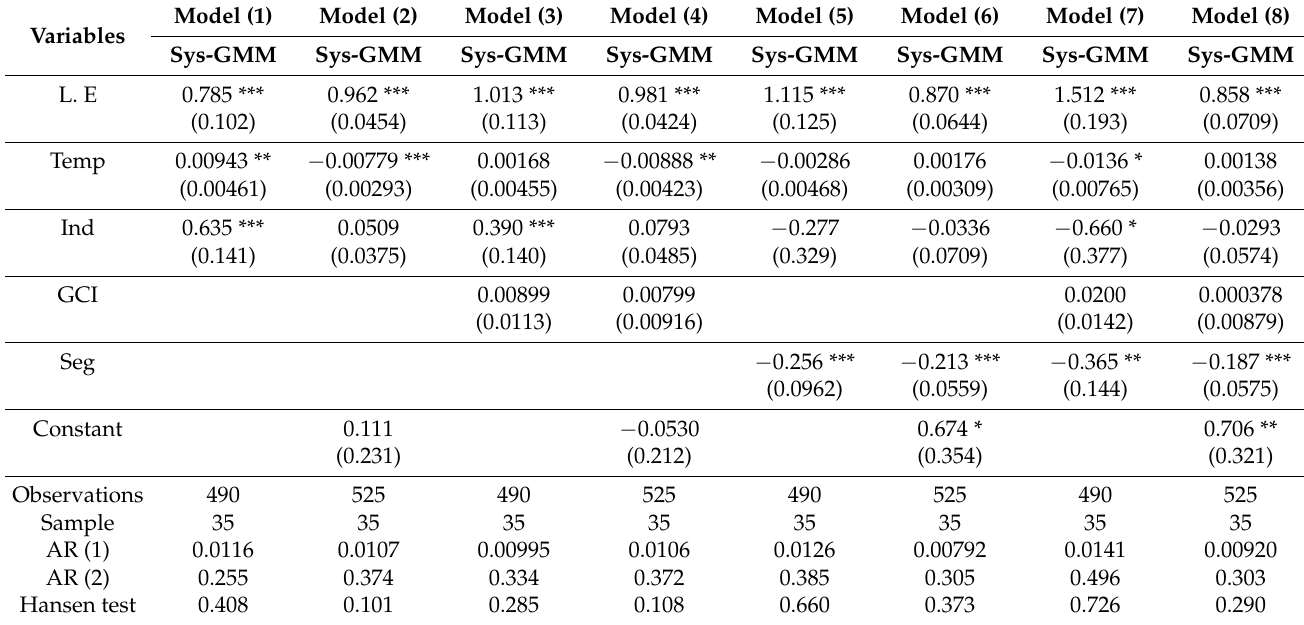
Table 5. The energy consumption function